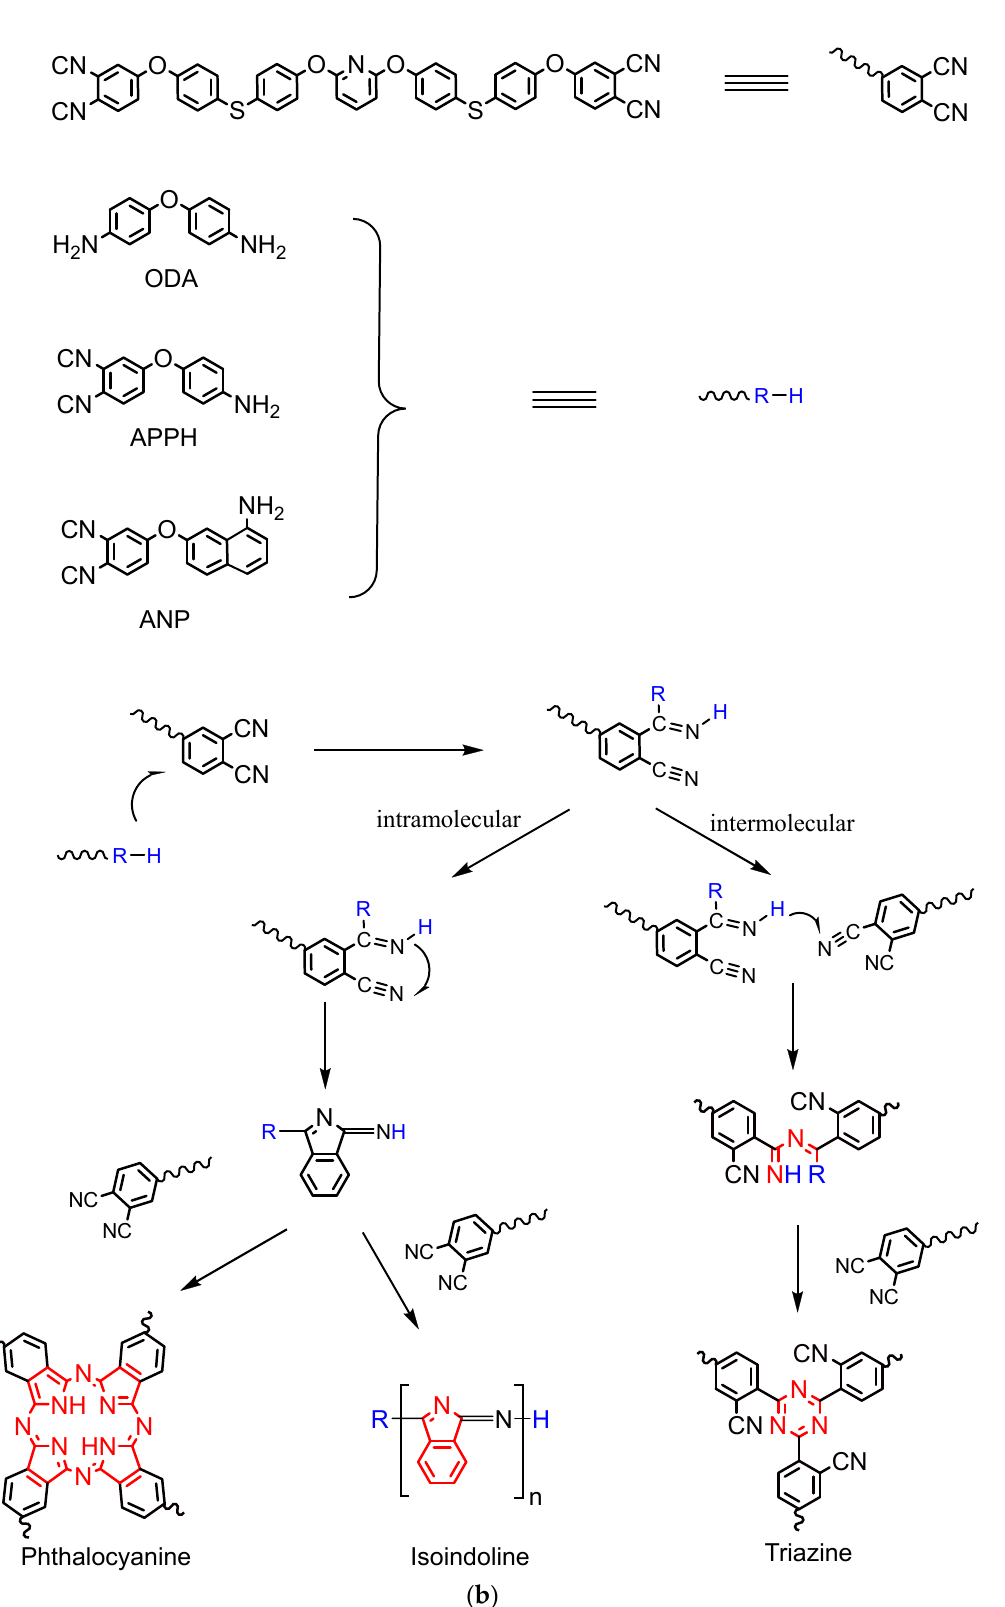
Figure 1. ( a ) Synthetic route of the DPTP monomer and polymer. ( b ) Curing mechanism of DPTP polymer. Table 1. Curing process of PN resin.